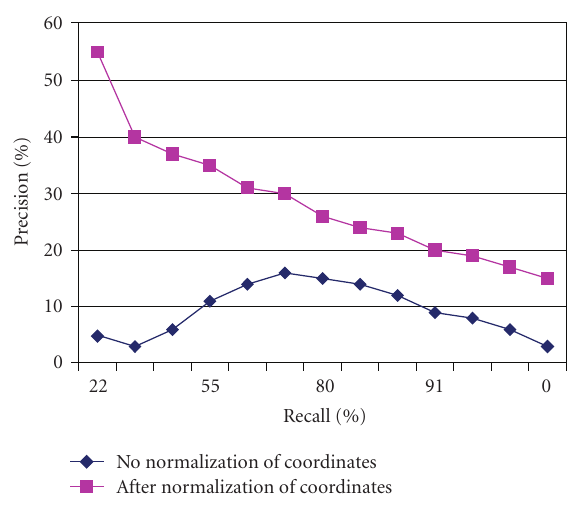
Figure 13: Precision recall of stool model.